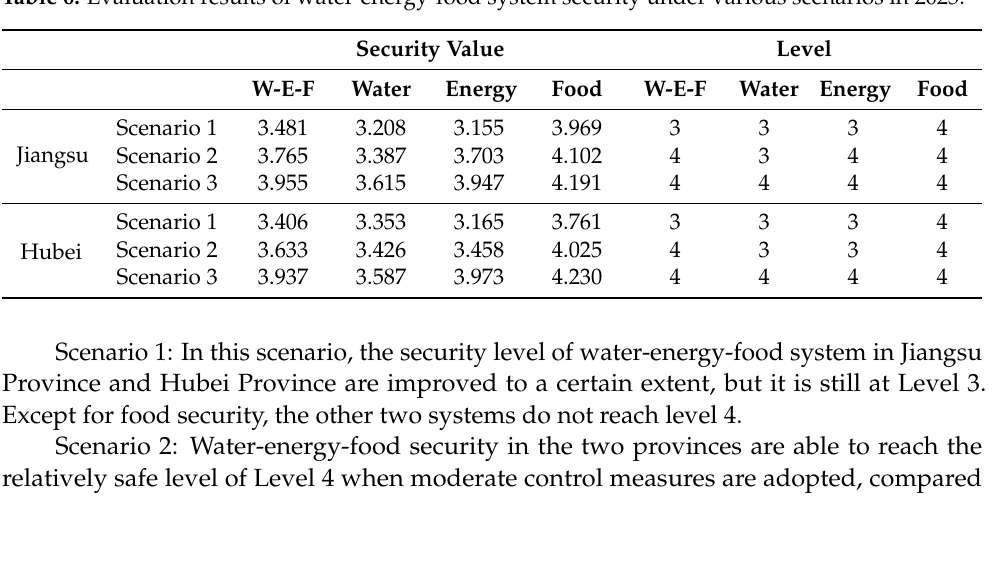
Table 6. Evaluation results of water-energy-food system security under various scenarios in